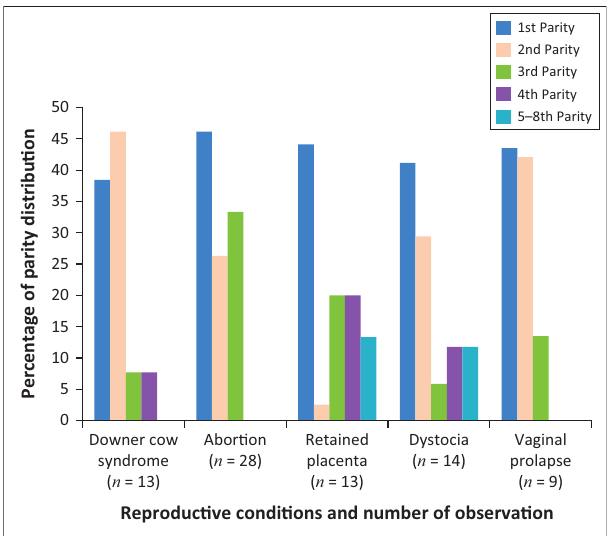
FIGURE 1: Parity distribution of cows affected by reproductive conditions parities.